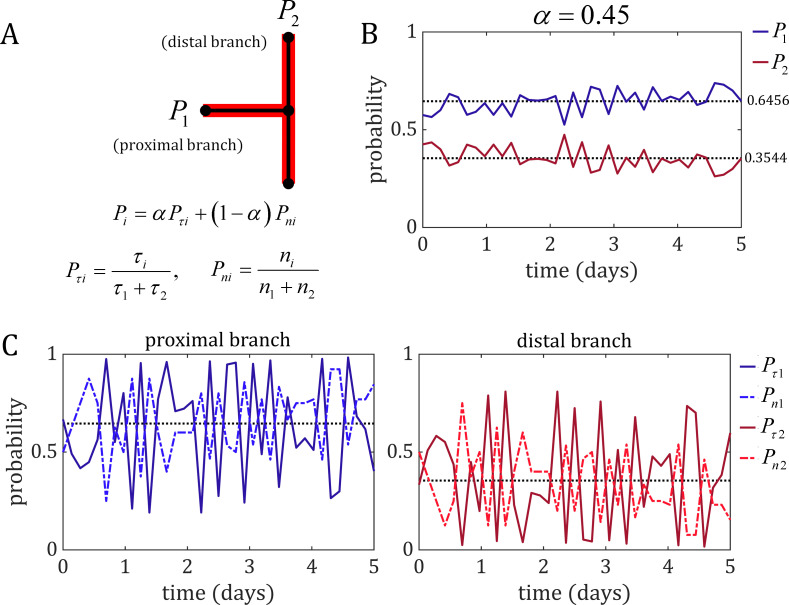
Competitive oscillations between the flow-based mechanism (shear stress) and collective-based mechanism (junction forces) achieves bifurcation stability.(A) The probability of each branch of pulling in new cells at the bifurcation, Pi, is given by the weighted average of the shear stress probability Pτi and the cell number probability Pni. (B) The branch probability over time for an example stable simulation with a value of α = 0.45. The branch probability at the bifurcation oscillated slightly over time, with the probability of the high-flow proximal branch averaging to a higher value (dark blue, mean 0.6456) than the low-flow distal branch (dark red, mean 0.3544). (C) The individual components of these probabilities also oscillate over time in both the proximal branch (left) and the distal branch (right), with alternating peaks in shear stress (dark blue/red, solid line) and cell number probability (light blue/red, dashed-dot line). Additionally, a peak in either component in one branch was accompanied by a trough the that same probability component in the other branch. These data suggest that the shear stress and cell number components interact competitively at stable bifurcations, each compensating for increases in the other to prevent either of the two components from dominating the bifurcation (which would result in a loss of one of the two branches).